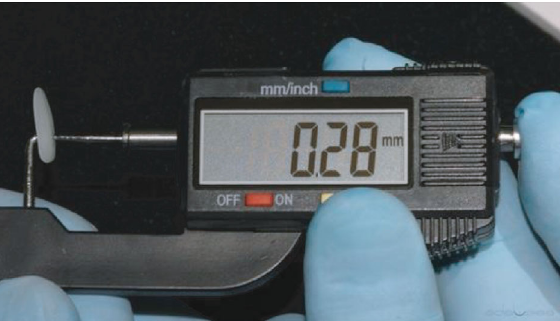
Figure 6: Final veneer thickness measured with a digital